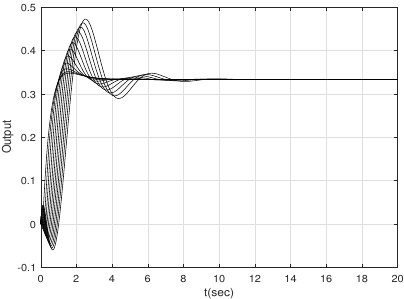
Figure 5. Unit step responses of the system (the first order approximation) with the second order Pade for h = 0 . 1 : 0 . 1 : 1 .